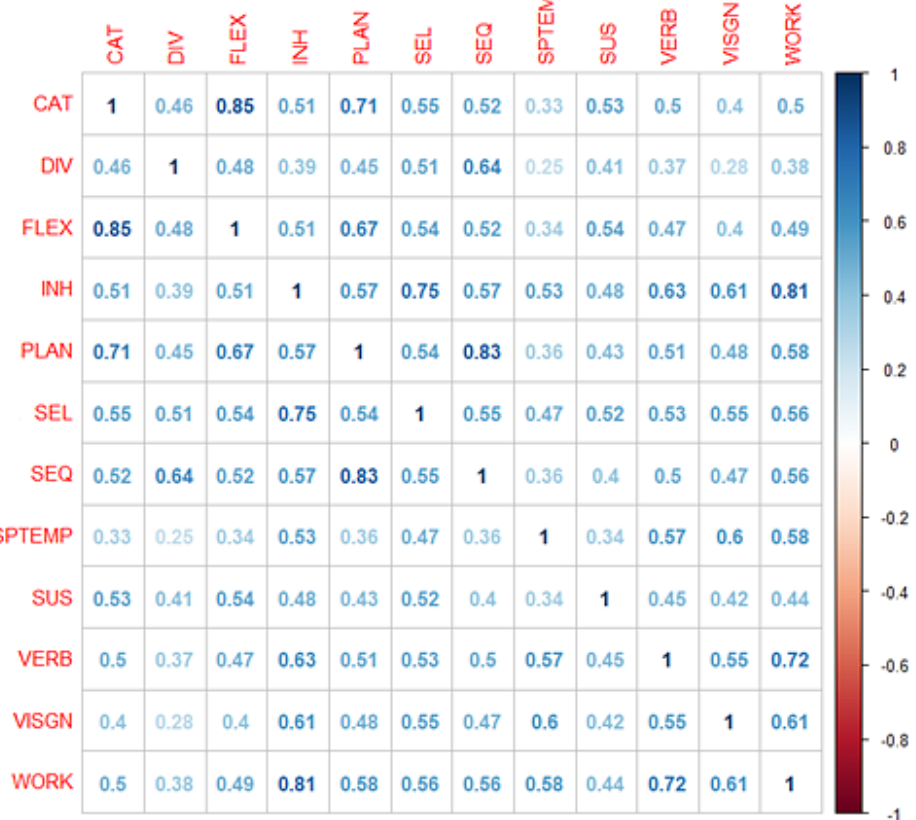
Figure 1. Correlogram of the initial set of cognitive variables. CAT: categorization; DIV, divided attention; FLEX: flexibility; INH: inhibition; PLAN: planning; SEL: selective attention; SEQ: sequencing; SPTEMP: spatiotemporal perception; SUS: sustained attention; VERB: verbal memory; VISGN: visual gnosis; WORK: working